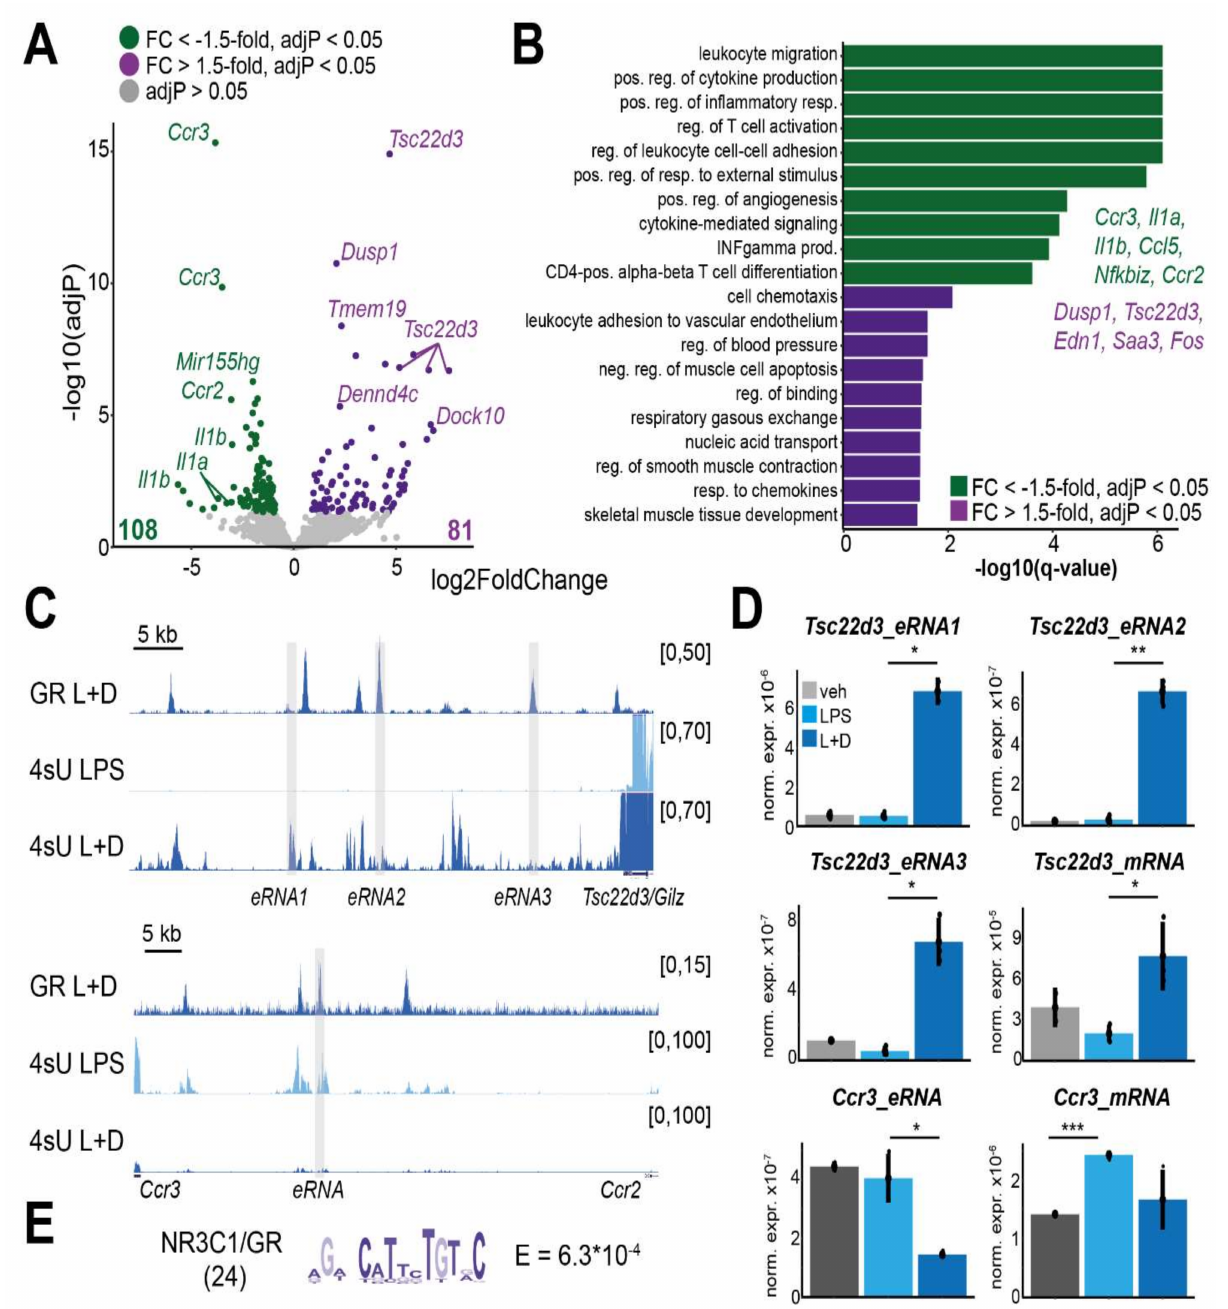
Figure 3. Glucocorticoids regulate differential eRNA expression. ( A ) Volcano plot displaying inter- genic GBSs showing differential eRNA expression in LPS + Dex versus LPS-treated macrophages. Each dot represents one eRNA-producing GBS. Selected eRNAs are named by the closest TSS. ( B ) “Bi- ological process” overrepresentation analysis of genes associated with Dex-induced or Dex-repressed eRNAs. Top 10 non-redundant processes with a q-value cutoff of 0.05 are shown and examples labelled. ( C ) Mean genome browser tracks of GR ChIP-seq (LPS + Dex; L + D, n = 2) and 4sU-seq coverage for LPS and LPS + Dex treated macrophages ( n = 3). Shades indicate positions of qRT-PCR primers for D. ( D ) RT-qPCR for Tsc22d3 ( Gilz ) and Ccr3 and their eRNAs in macrophages treated with vehicle, LPS or LPS + Dex ( n = 3). *** p < 0.001, ** p < 0.01, * p < 0.05 (Students t -test) ( E ) Differential motif enrichment analysis for GR-bound sites with activated eRNA expression over those with reduced expression. (24: number of sites with motif